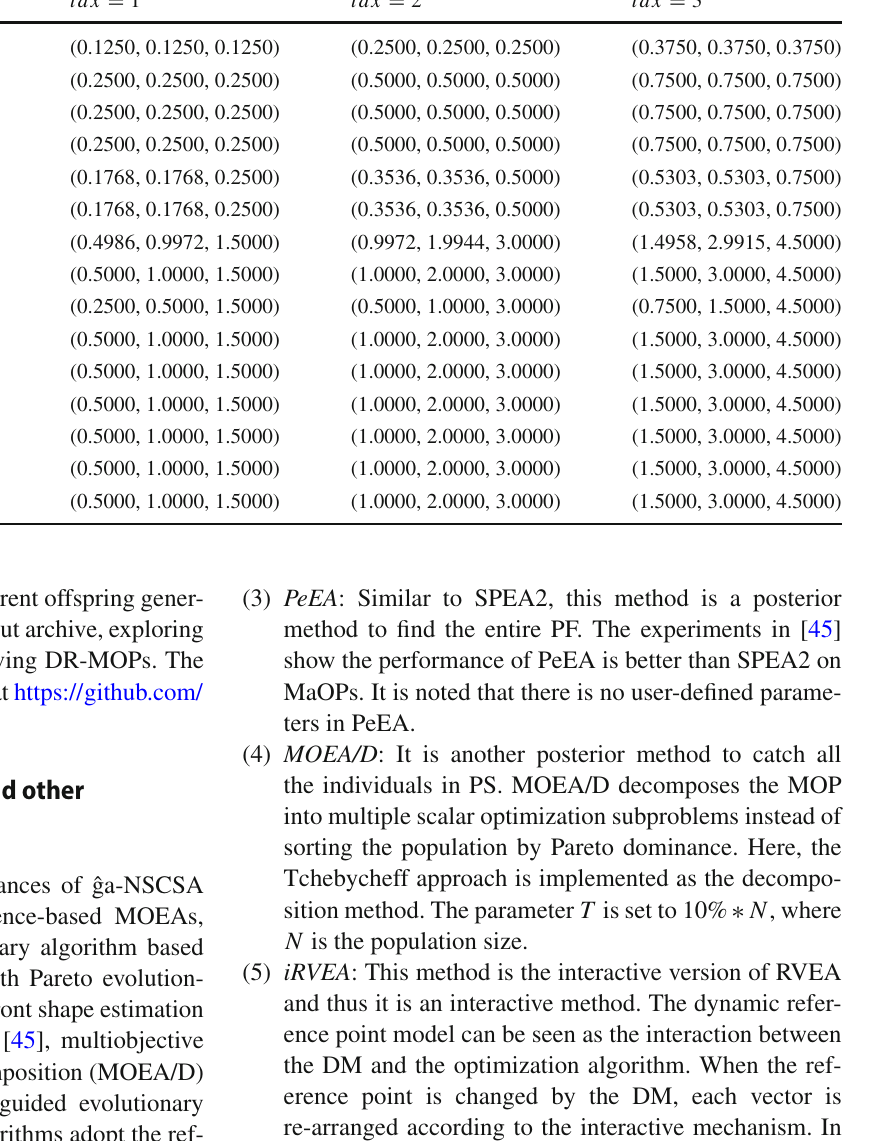
Table 1 Initial reference points in different